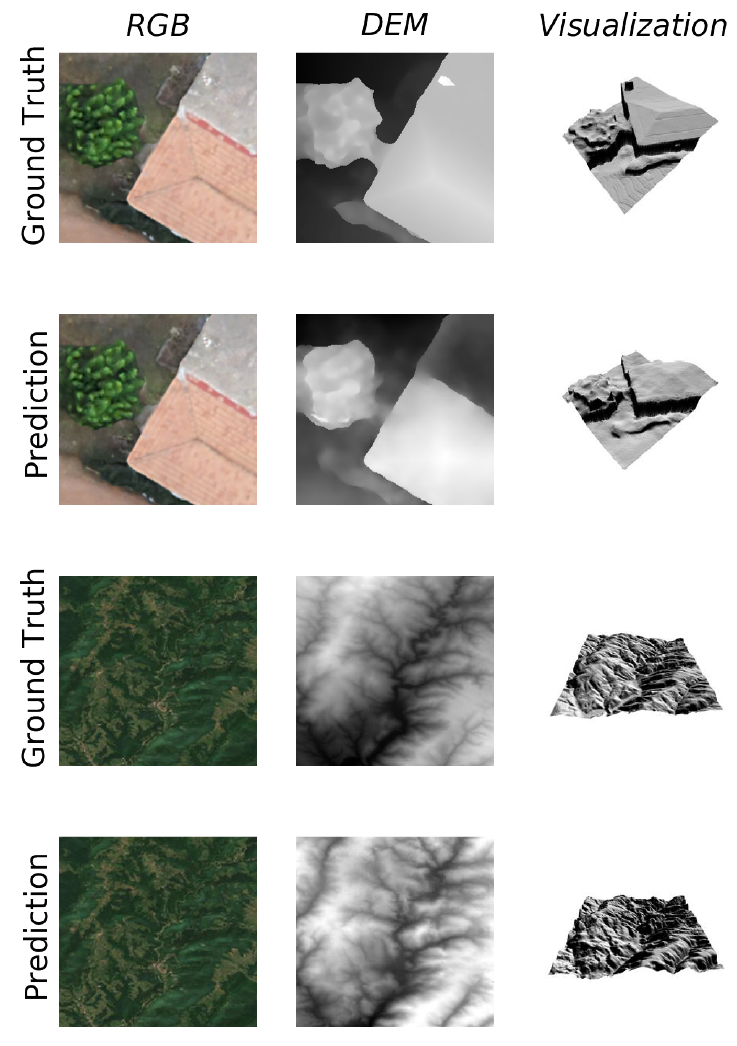
Figure 11. 3D visualizations of the some predictions of pix2pix compared to the ground truths. The top two rows depict samples from the rural drone-borne dataset, while the last two from the satellite dataset. The input drone and satellite images are from the test